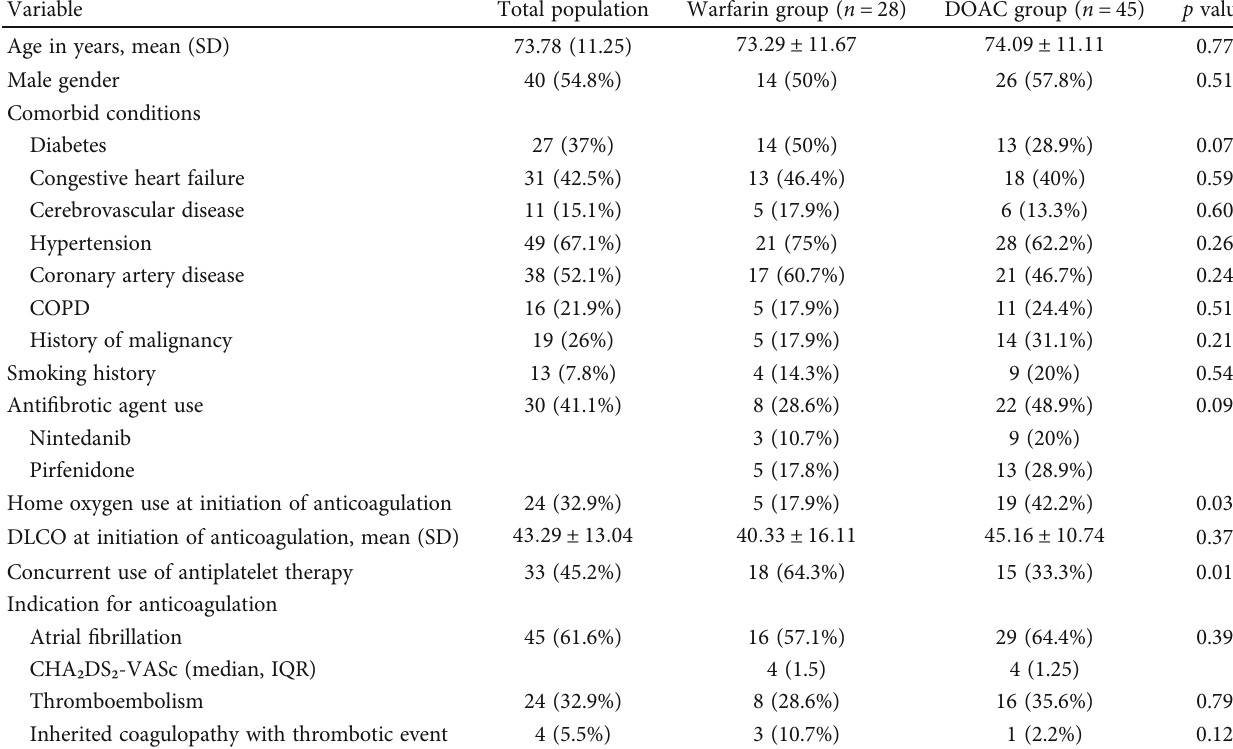
Table 1: Baseline characteristics of the study population.